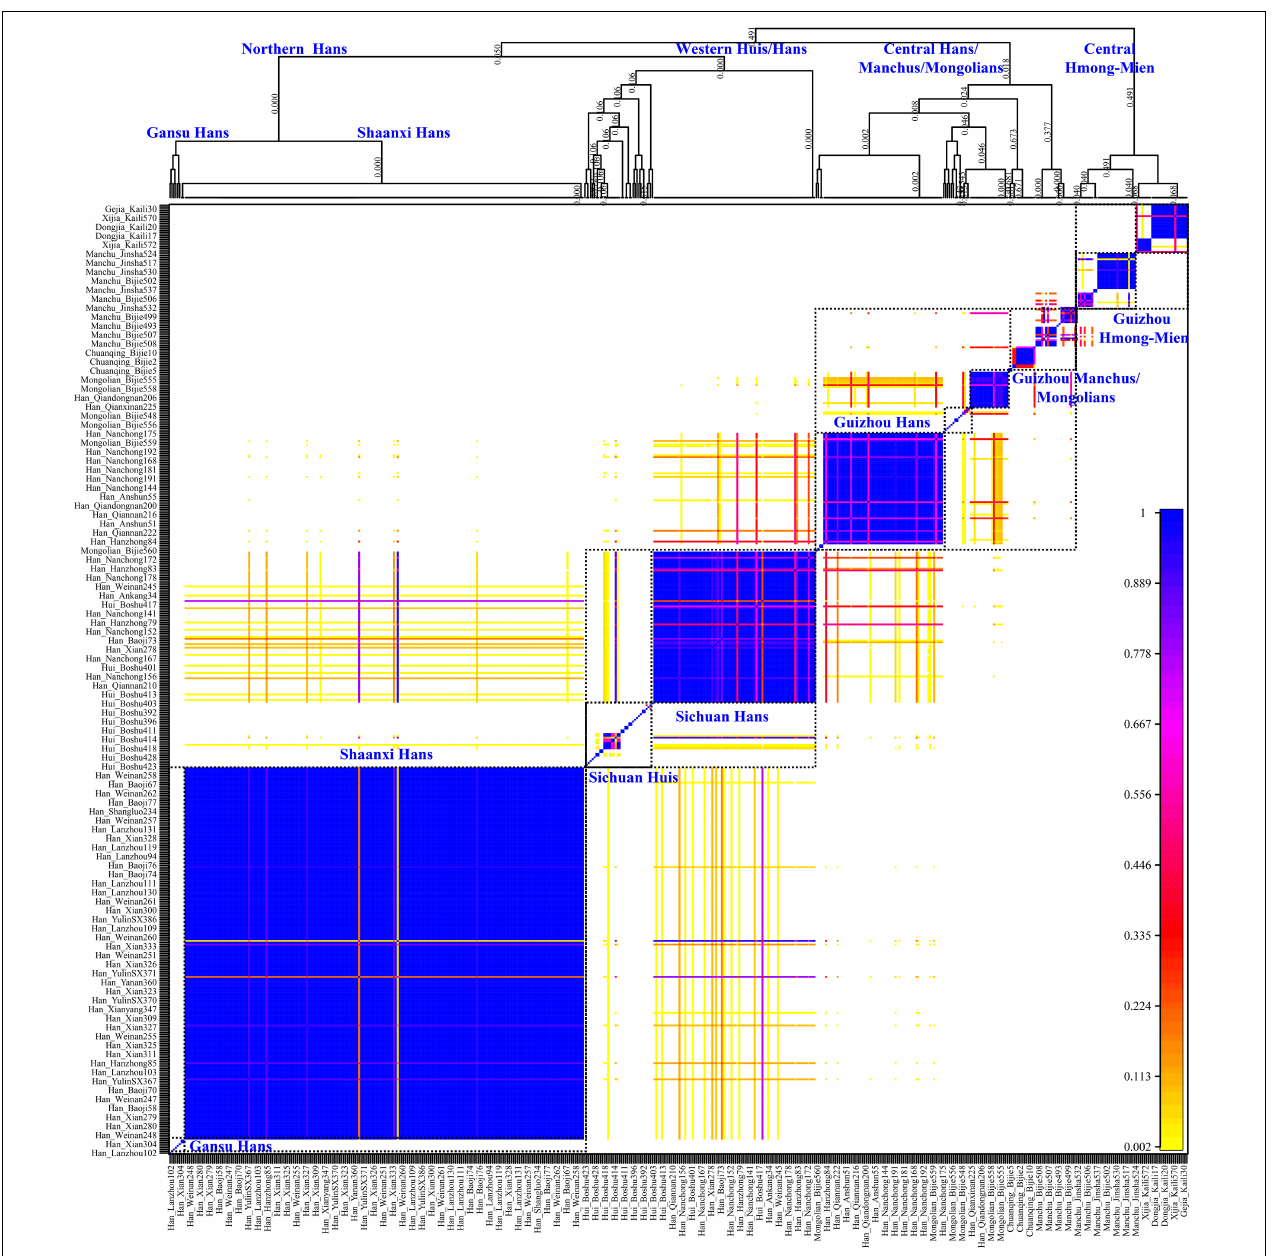
FIGURE 6 | Genetic structure of Chinese populations from haplotype analysis using fineSTRUCTURE. The top parts showed the dendrogram of the genetically homogeneous populations and the bottom heatmap showed the pairwise coincidence. No meaning of the branch lengths but the hierarchy denoted the branching pattern clustered based on the haplotype